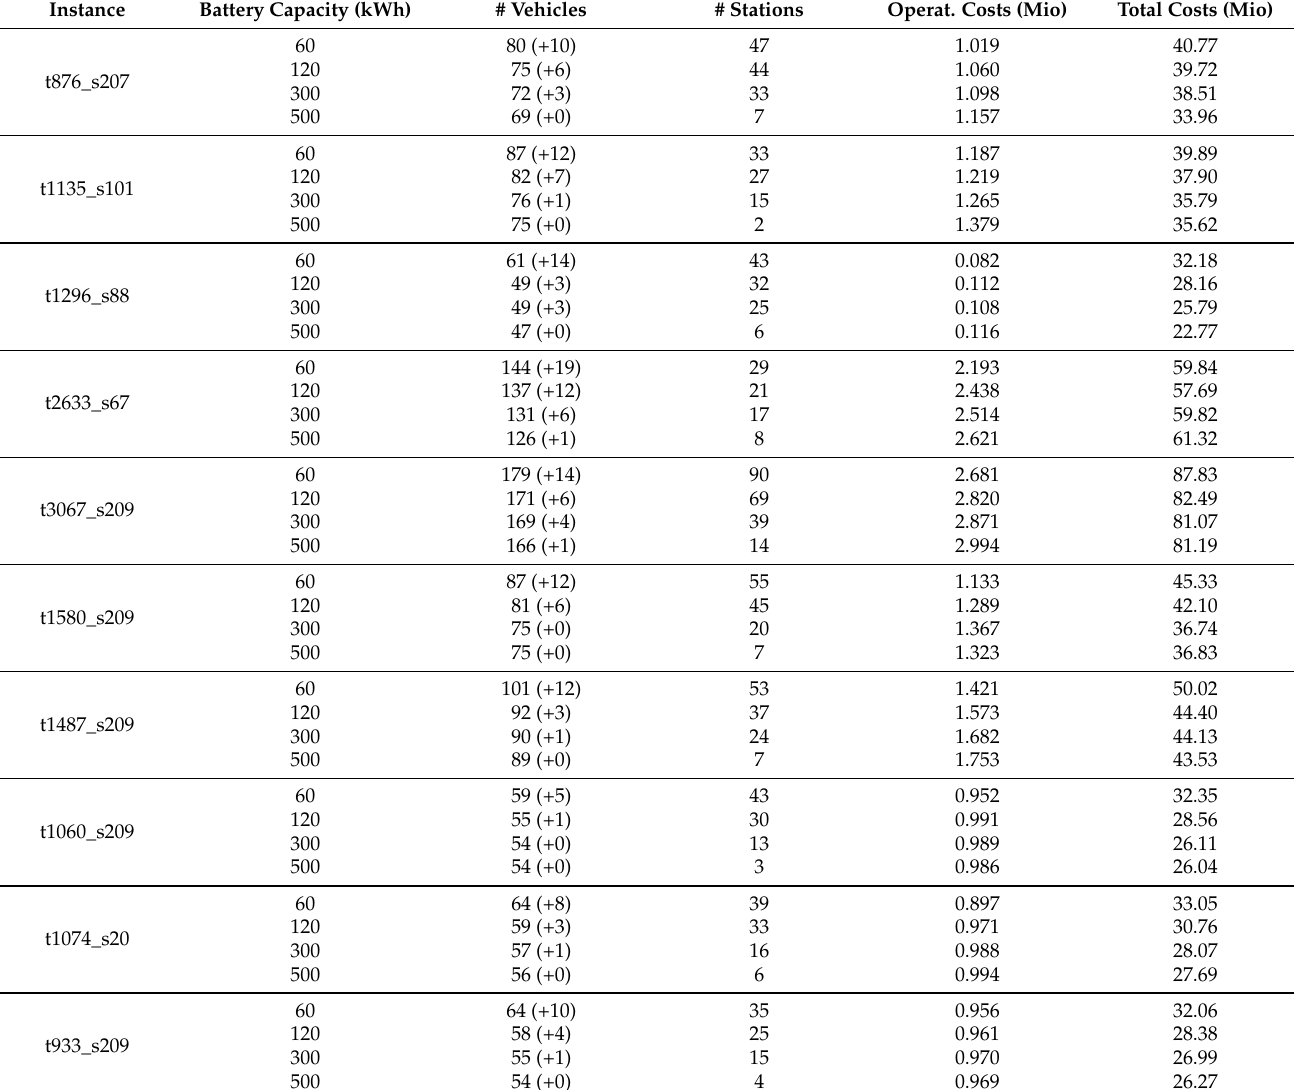
Table 3. Results of solving an E-VSP given locations of charging stations by reduced Algorithm 1 incorporating partial charging